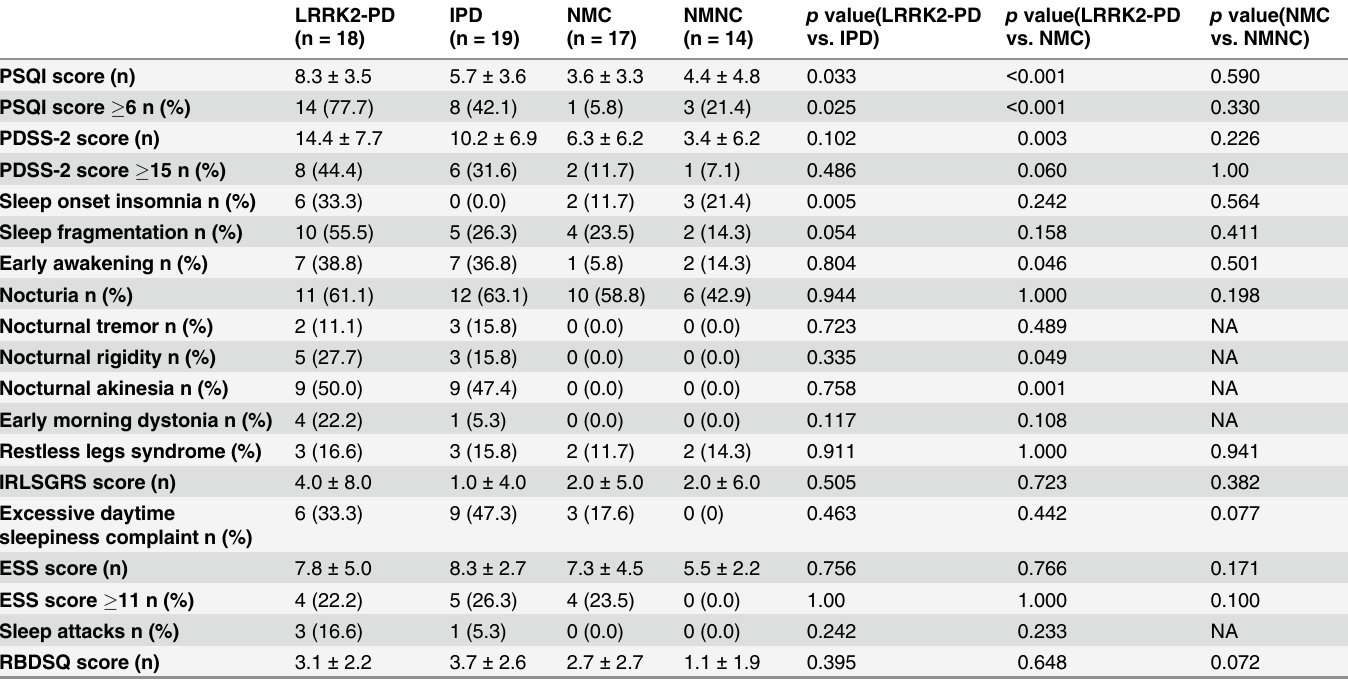
Table 2. Sleep related clinical data and comparisons between